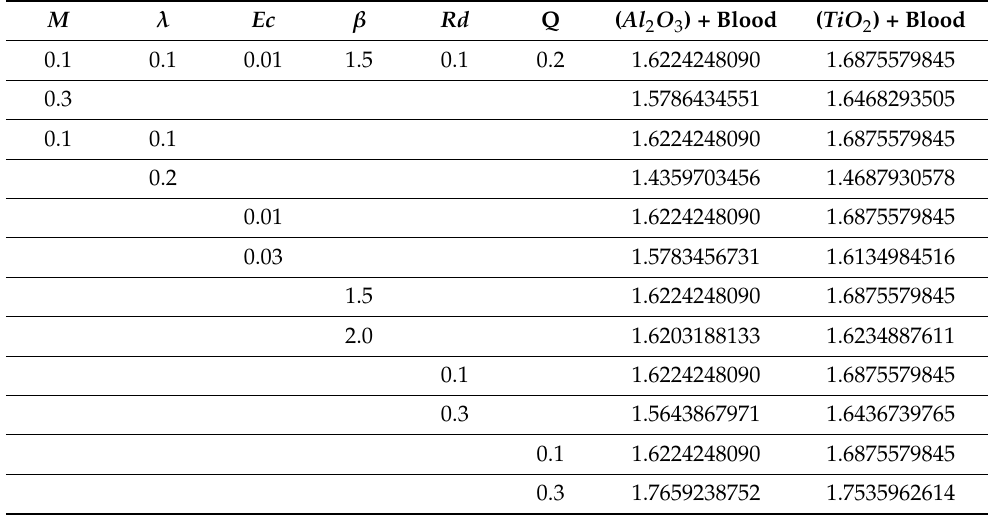
Table 5. Computed values of Re − 1 2 Nu against several values of β , M , Q , Rd , Ec , and Pr when ξ = 0.1.